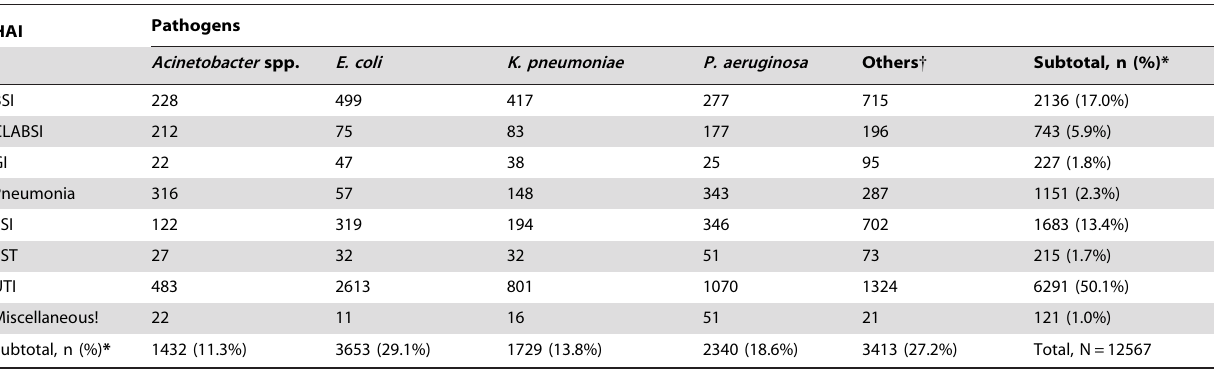
Table 2. Numbers of healthcare-associated infection (HAI) and the pathogenic Gram-negative bacilli from 2002 to 2009 at